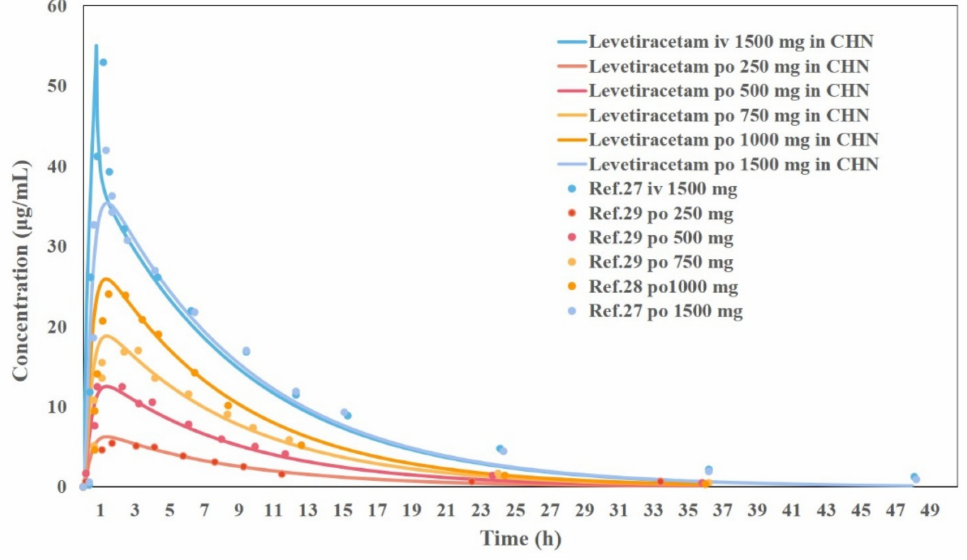
Figure 3. Validation results of the PBPK model with different dosing regimens (the solid line is the prediction result and the dashed line is the validation result).